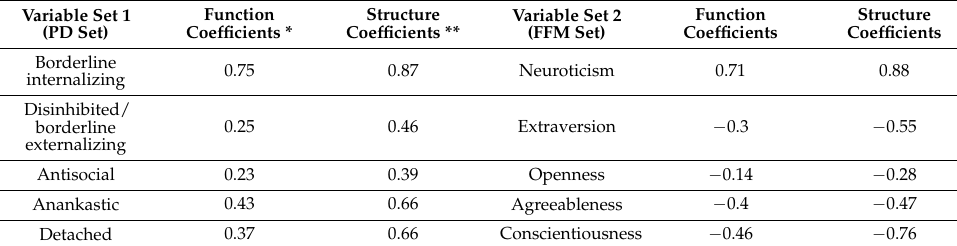
Table 2. Function coefficients and structure coefficients for the first quasi-canonical